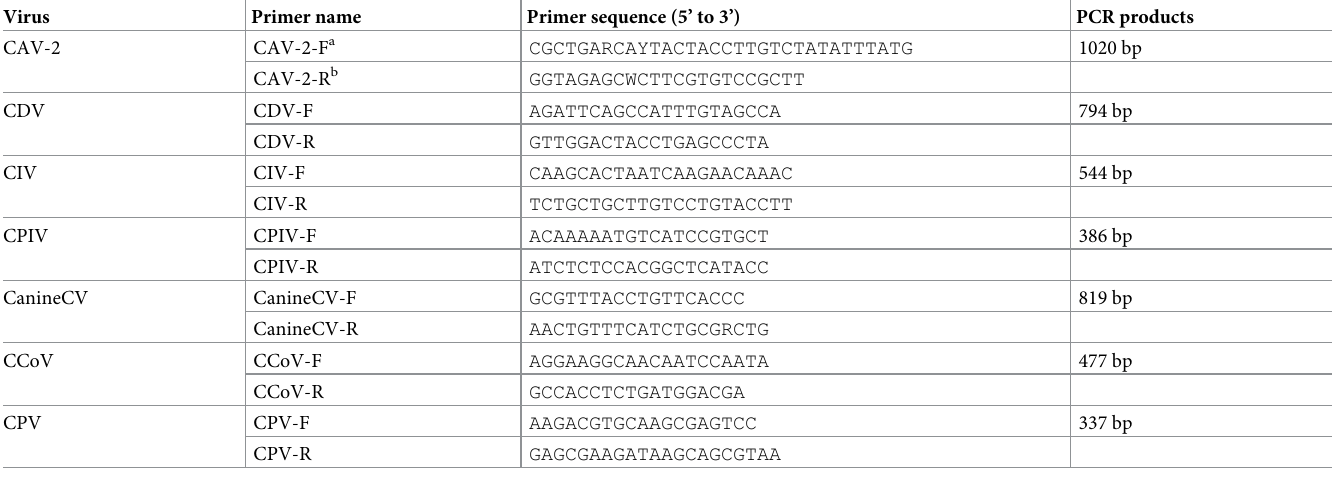
Table 1. Primers used for PCR amplification of CRV and CEV.